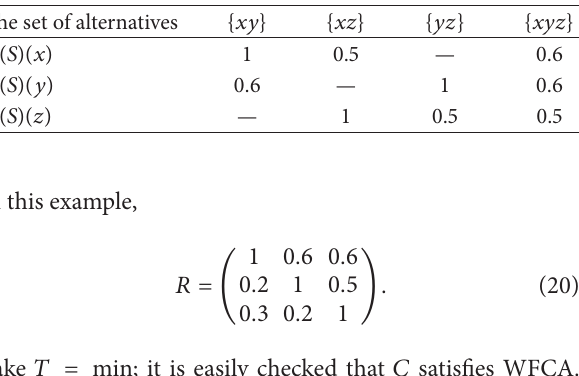
Table 1: The degree of the expert’s